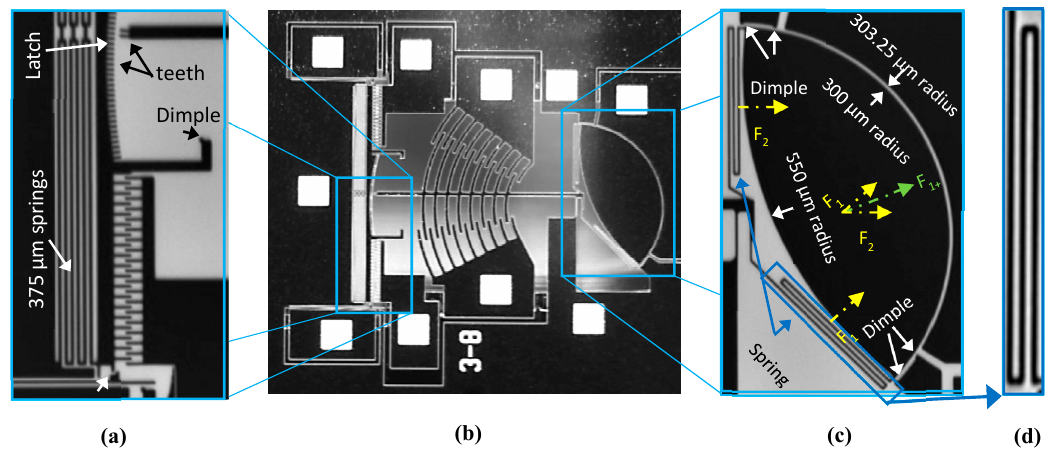
Figure 3. Scanning electron microscope (SEM) micrographs of the third design: ( a ) latch and latch lock, ( b ) whole device illustrating the curved back facet, ( c ) gap-closing structure where the yellow-dashed arrows show springs displacements, and the green-dashed arrow shows the gap closer resulting displacement, and ( d ) spring.